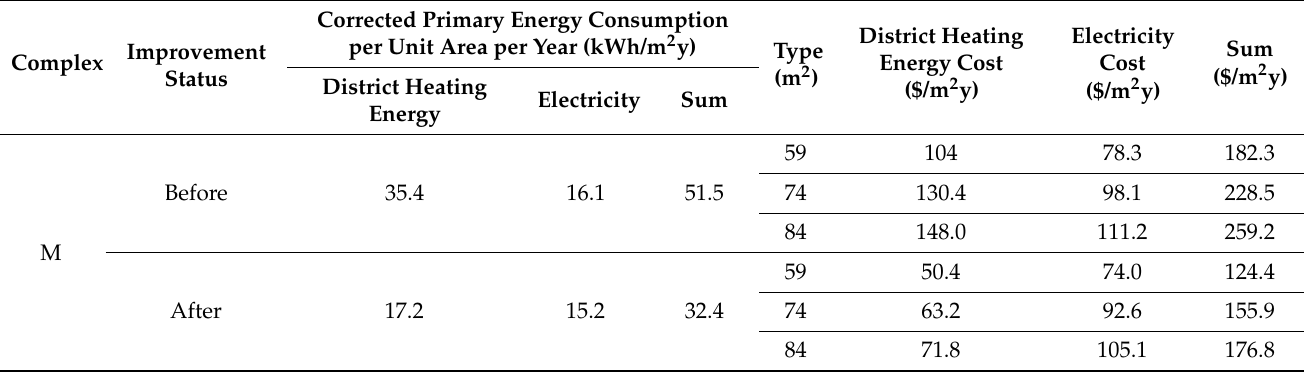
Table 11. Energy cost of district heating energy and electricity for the M complex before and after improvement. (Currency: 1$ ≒ 1200 KRW, as of 7 January 2022).